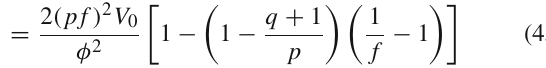
Fig. 1 Parameter spaces matching observations for the case p = 2 ( q + 1 ) = 4. Top-Left : (φ 0 , M ) satisfying g ( M ,φ 0 ) = | η ∗ | , Top- Right : (κ, H ∗ ) , Bottom-Left : (κ,φ ∗ /φ 0 ) , Bottom-Right : (κ, r ) . In each